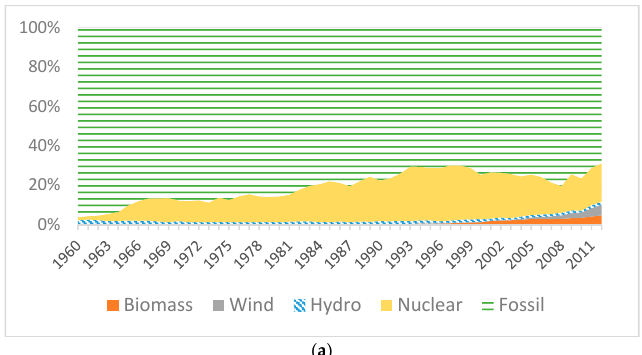
Table 3. Assumptions used under base and alternative methods for industrial